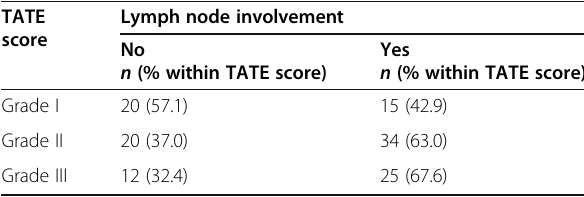
Table 5 Showing association between final stage and